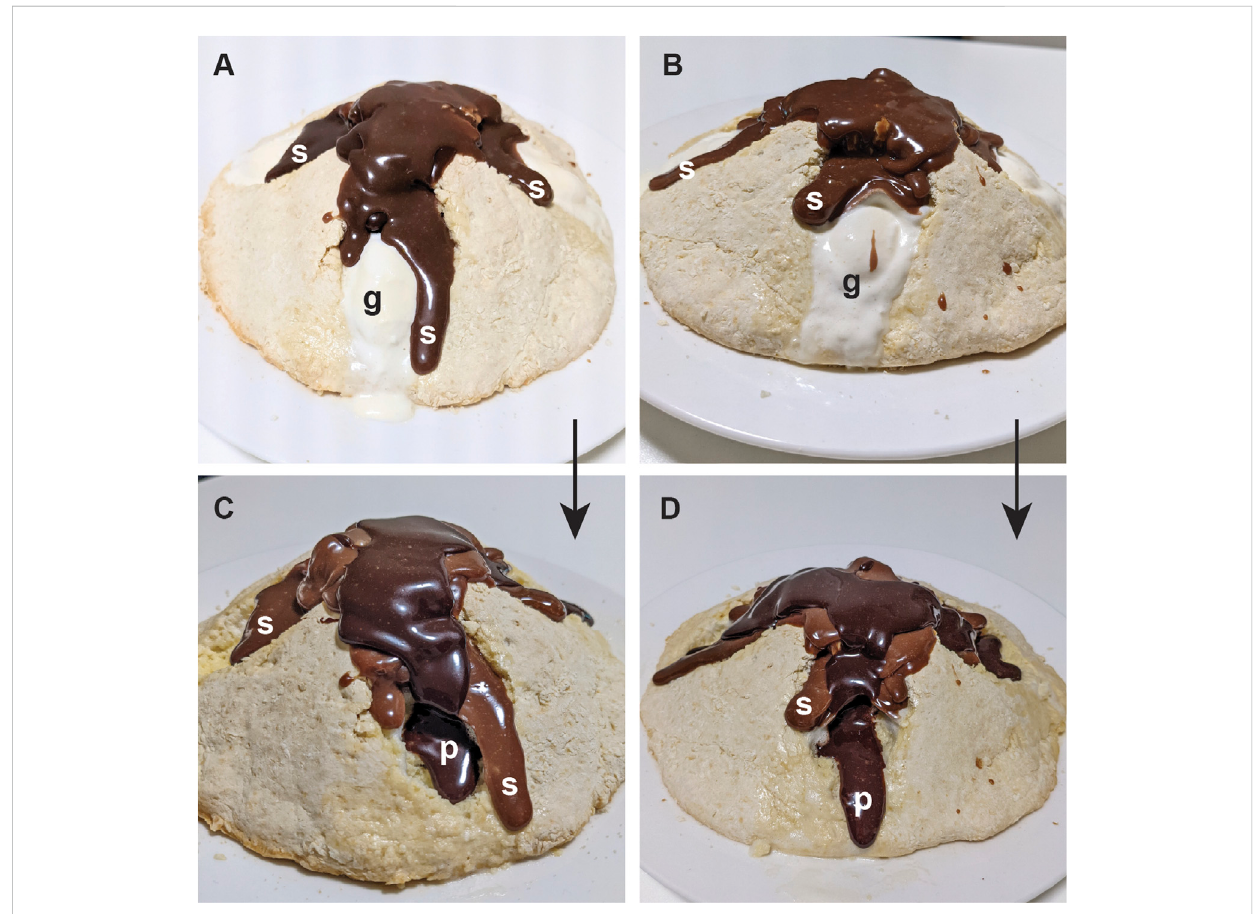
FIGURE 3 The experiment. (A,B) Syn-glacial lava fl ows (s) were de fl ected by glaciers (g) and emplaced along ridges during the glacial stage. (C,D) Post-glacial lavas (p) fl owed over older lavas and into ice-free valleys after